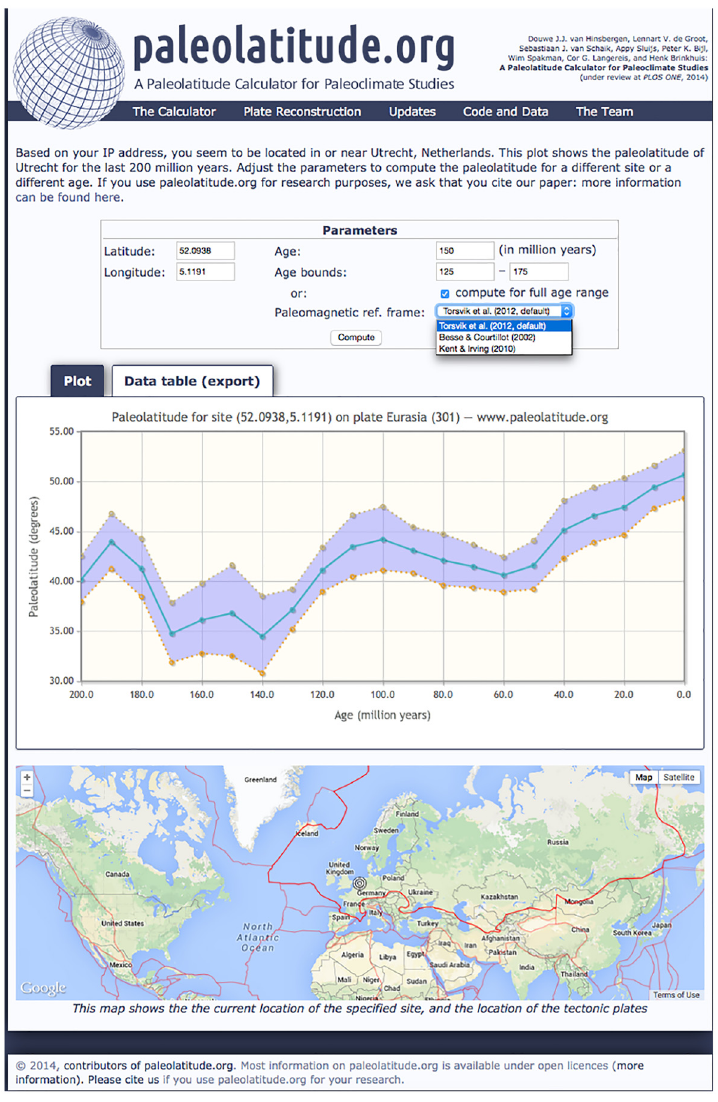
Fig 3. Screen shot of www.paleolatitude.org. In the top panel, site latitude and longitude is required (in decimal degrees), the age of the site, and the lower and upper age bounds. Center panel shows the paleolatitude with error bars in the period between the upper and lower bounds. The option ‘ compute for full age range ’ will calculate a paleolatitude curve using the full age range of the plate (fragment) on which the chosen site is located, which will appear in the center panel. Second tab in the center panel will provide a table with an output file for paleolatitudes with error bounds in the chosen time interval. Note that at the location of this site (e.g., close to a mid-ocean ridge) the plate may not have existed throughout this entire history. The bottom panel shows the location of the site on the modern topographic world map, as well as the plate (fragment) on which the site is located. Reprinted from www.paleolatitude.org under a CC BY license, with permission from S.J. van Schaik, original copyright